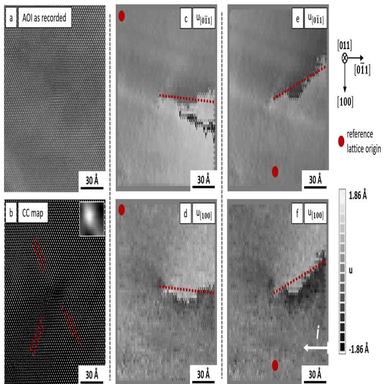
HR-STEM image of the AOI in the as-recorded state (a) and after template matching (b). The inset in (b) is an enlarged image of the spatially averaged template of a single column used for the cross correlation. The displacements in- and -direction obtained by TeMA are given for different referent lattice origins in sub-images (c,e) and (d,f), respectively. In any case, a clear discontinuity in the displacements is present with its average orientation (highlighted by the red dashed lines) depending on the ar